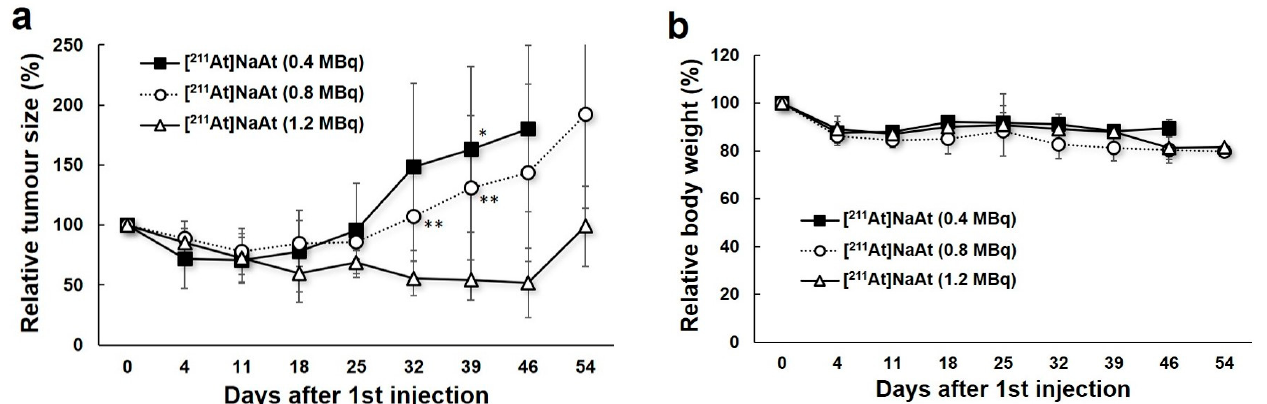
Figure 5. Changes in the relative tumour size ( a ) and relative body weight ( b ) in the 0.4 MBq 211 At, 0.8 MBq 211 At, and 1.2 MBq 211 At group. * p < 0.05 between the 0.4 MBq and 1.2 MBq groups; ** p < 0.05 between the 0.8 MBq and 1.2 MBq groups.